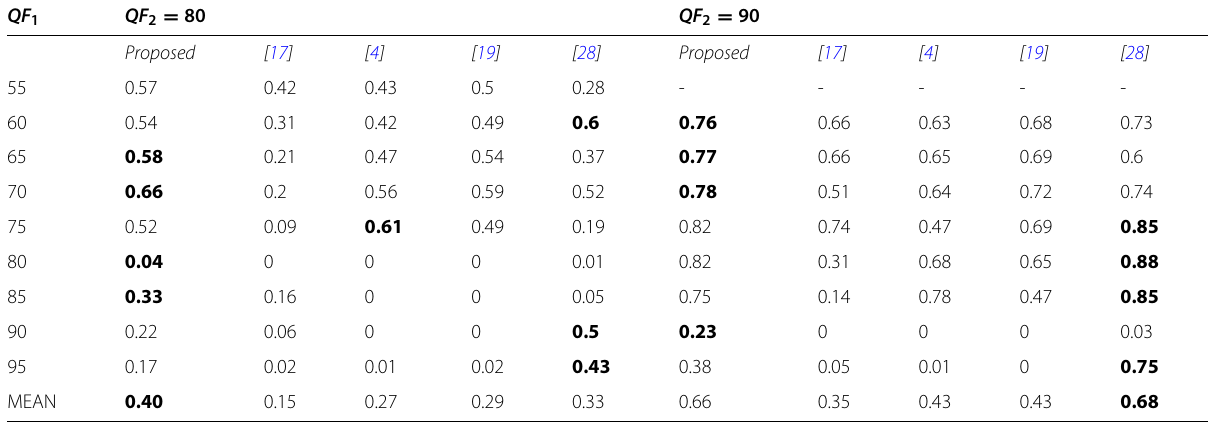
Table 1 Accuracy obtained by proposed approach compared to Bianchi et al. ([17]), Galvan et al. ([4]), Dalmia et al. [19] and Niu et al. ([28]) with different combinations of QF 1 / QF 2 by considering the standard quantization tables